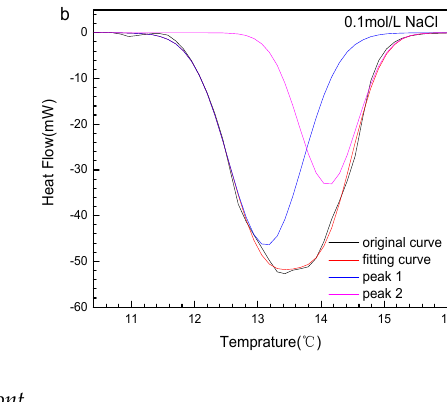
Figure 8. Phase equilibrium curves of methane hydrate in montmorillonite [23,51].